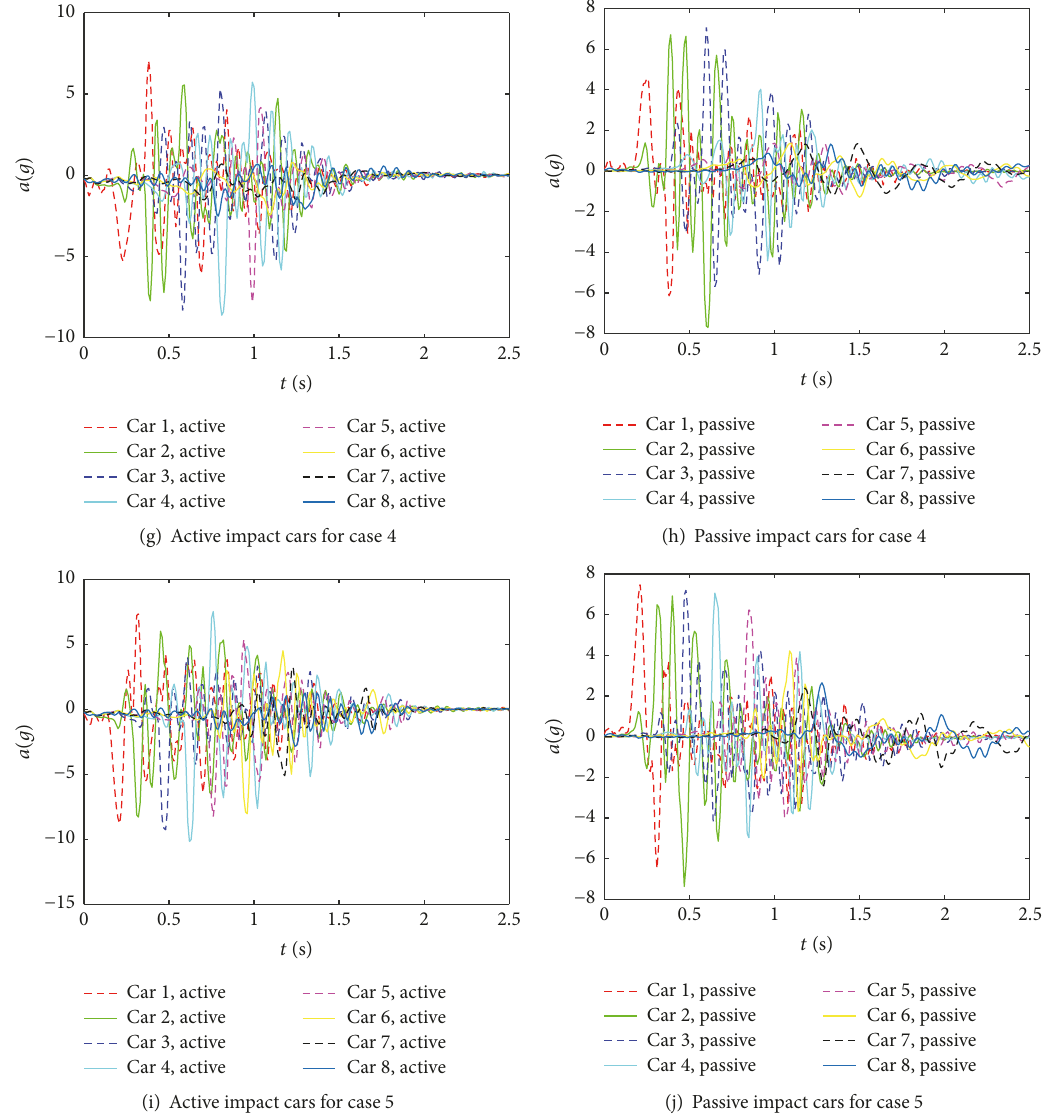
Figure 10: Individual acceleration-time curve for all